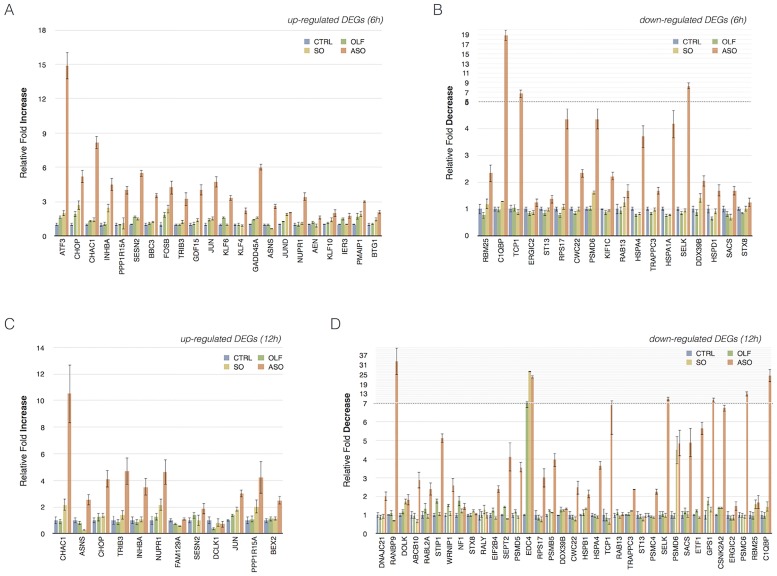
qPCR verification of DEGs.Graphs show relative fold change values of up-regulation (A and C) and down regulation (B and D) of selected genes. The results, normalized to β-actin, were averaged from values obtained by performing three technical replicates. The values are means ± SD.